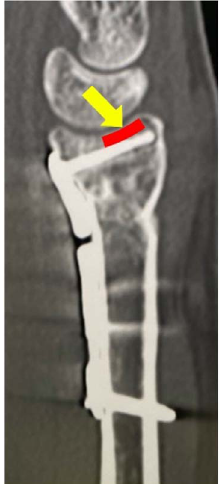
Figure 2. The theory of osteosynthesis and surgical technique of PVLP. In order to prevent dorsal re-displacement, it will be more important to obtain good subchondral support of the dorsal side of the radial facet with PVLP compared with buttress effect by covering the volar lunate facet fragment ( yellow arrow : the dislocation direction of the carpal, red line : the dorsal side of the radial facet supported by the locking screw).